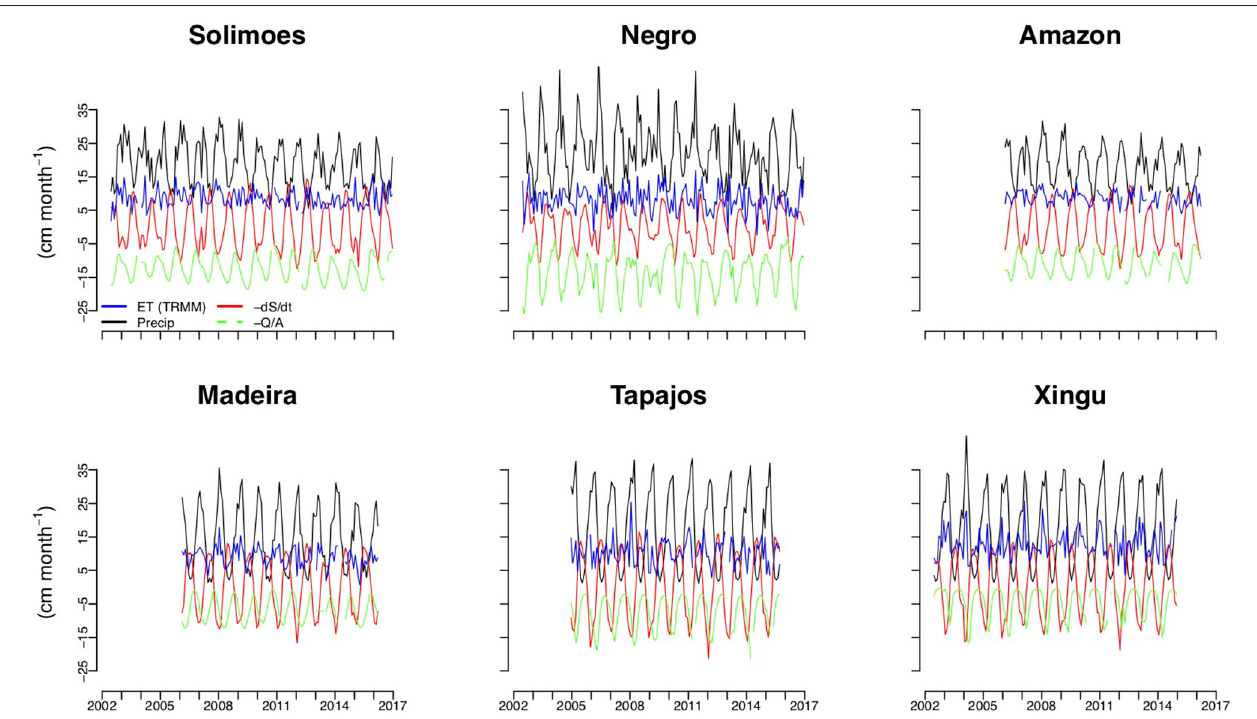
FIGURE 2 | Long-term records of precipitation, river discharge, time rate of change of terrestrial water storage anomalies and evapotranspiration estimated from these